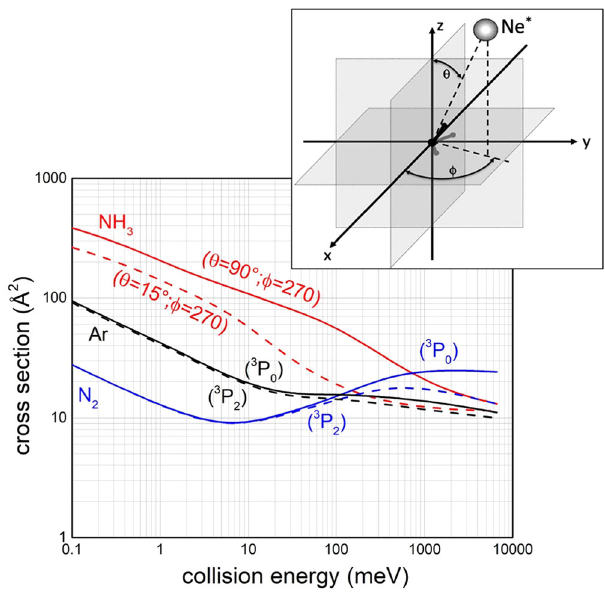
Fig. 1 Total ionization cross sections for Ne * ( 3 P) + Ar, N 2 , NH 3 CHEMI. They are calculated as a function of the collision energy using the Optical potentials formulated in refs. 7,8,25,34,35 . For Ar and N 2 the different reactivity of Ne * ( 3 P 2 ) reagent (dashed lines) with respect to that of Ne * ( 3 P 0 ) (full lines), with its dependence on the collision energy, is also resolved, which appears to be consistent with the experimental fi ndings 40 . For NH 3 the dependence of the reactivity on the precursor state geometry, opening the formation of NH 3 + in its ground (full line) and in its fi rst excited electronic state (dashed line), is shown. θ and φ are the polar angles as de fi ned in the inset of the